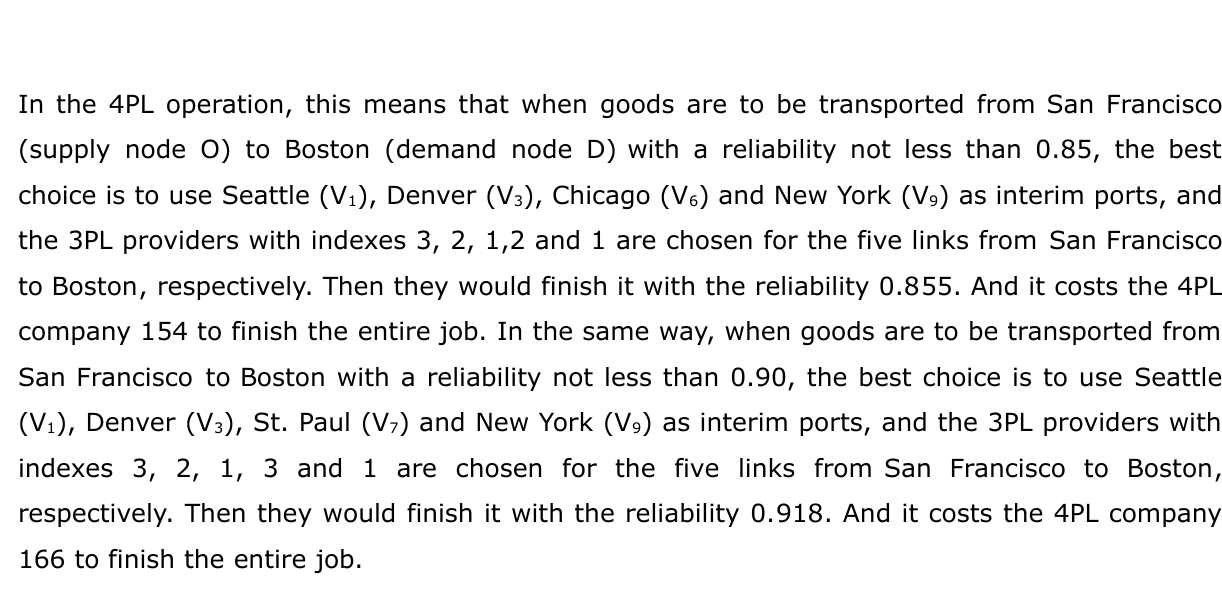
Table 3. Comparison of two algorithms with different reliability